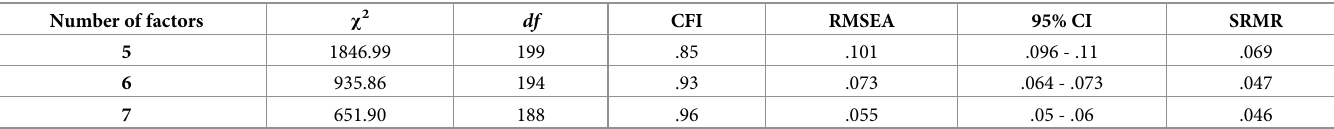
Table 2. Fit indexes of first-order factor